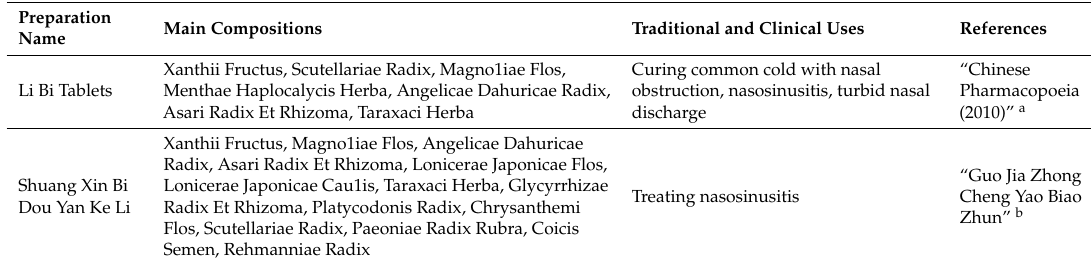
Table 1. The traditional and clinical uses of Xanthium strumarium in